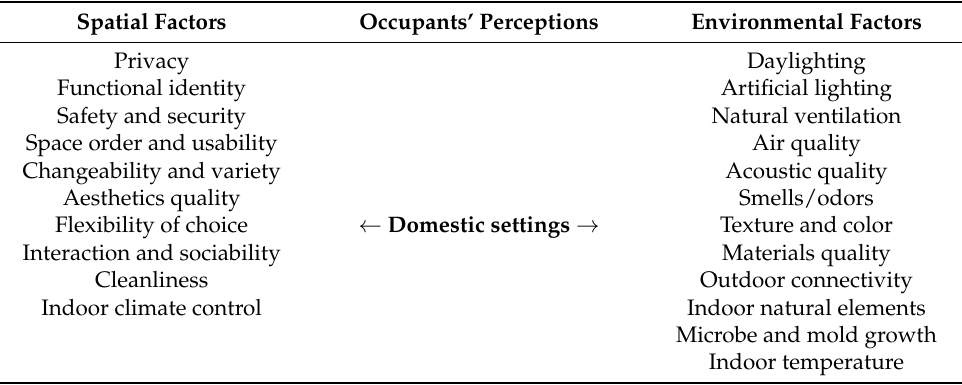
Table 2. Identification of different factors from field observation.